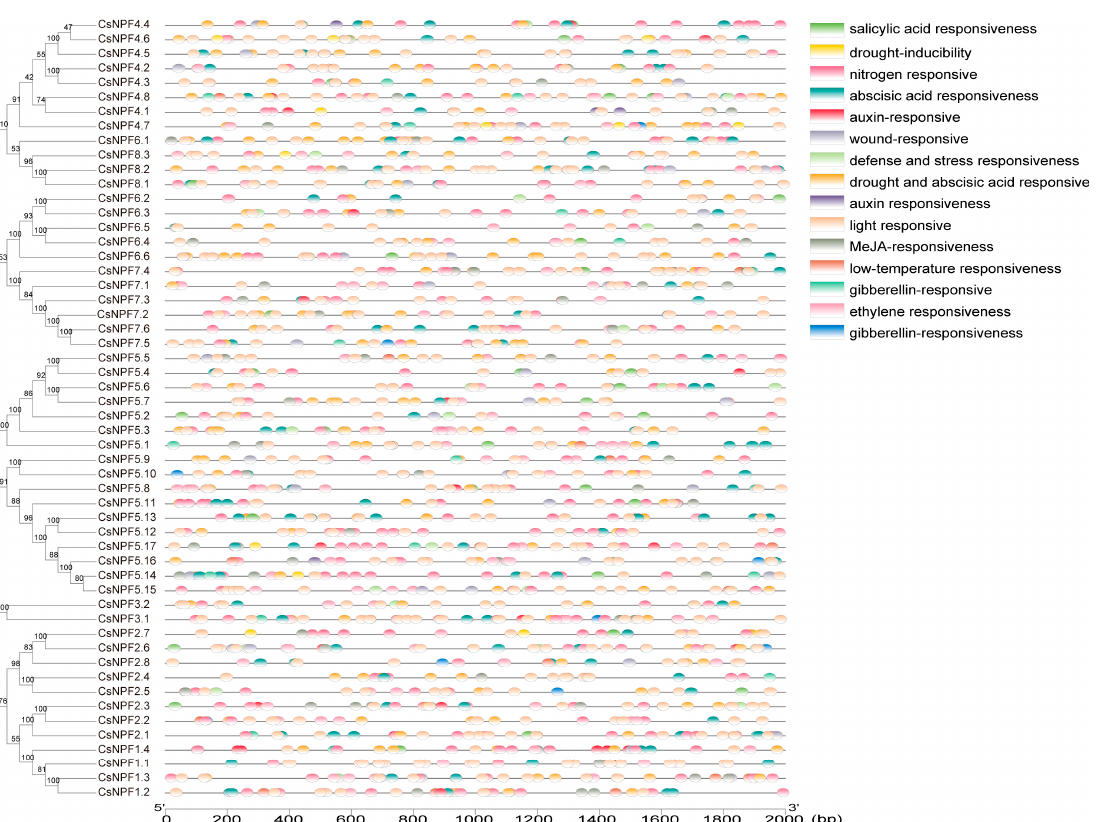
Figure 4. Cis ‐ acting regulatory element (CRE) analysis in the 2000 bp promoter regions of the 54 CsNPF genes.